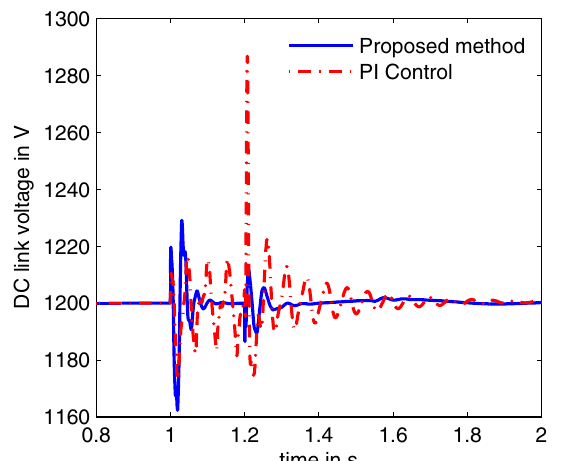
Fig. 7 DC voltage for a three-phase fault at bus 4